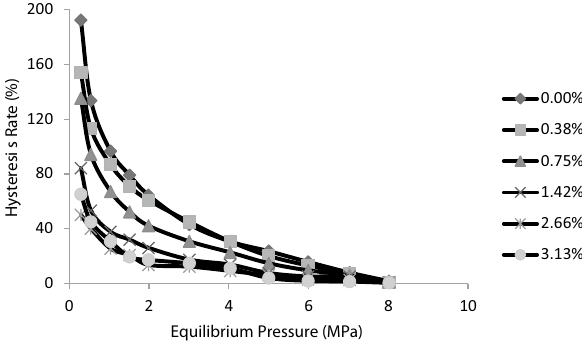
Fig. 5 Hysteresis rate under various moisture